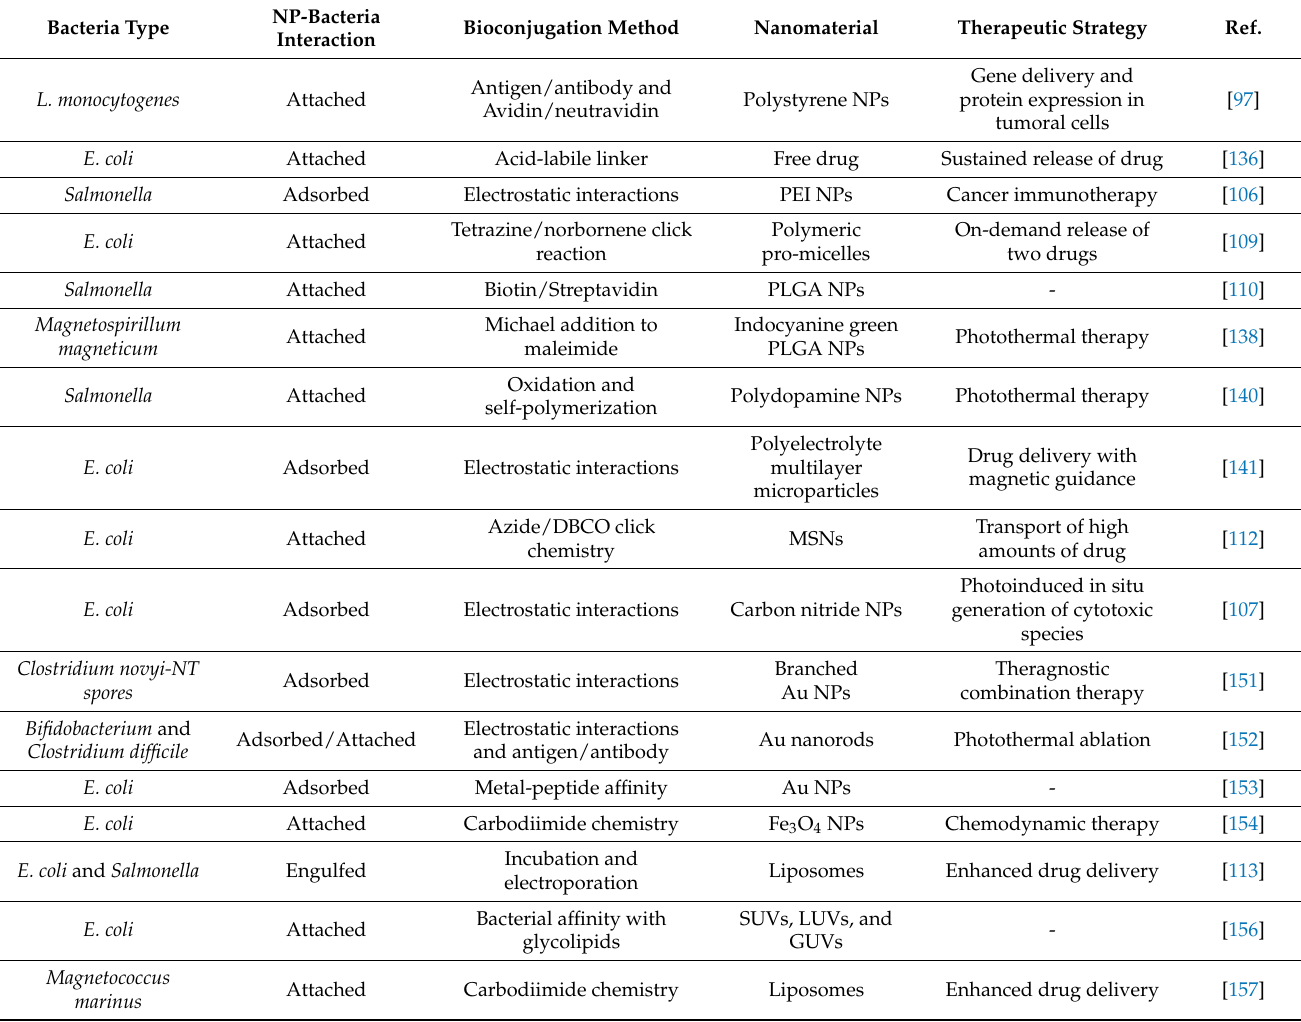
Table 2. Summary of bacteria-based biohybrid nanocarriers for cancer